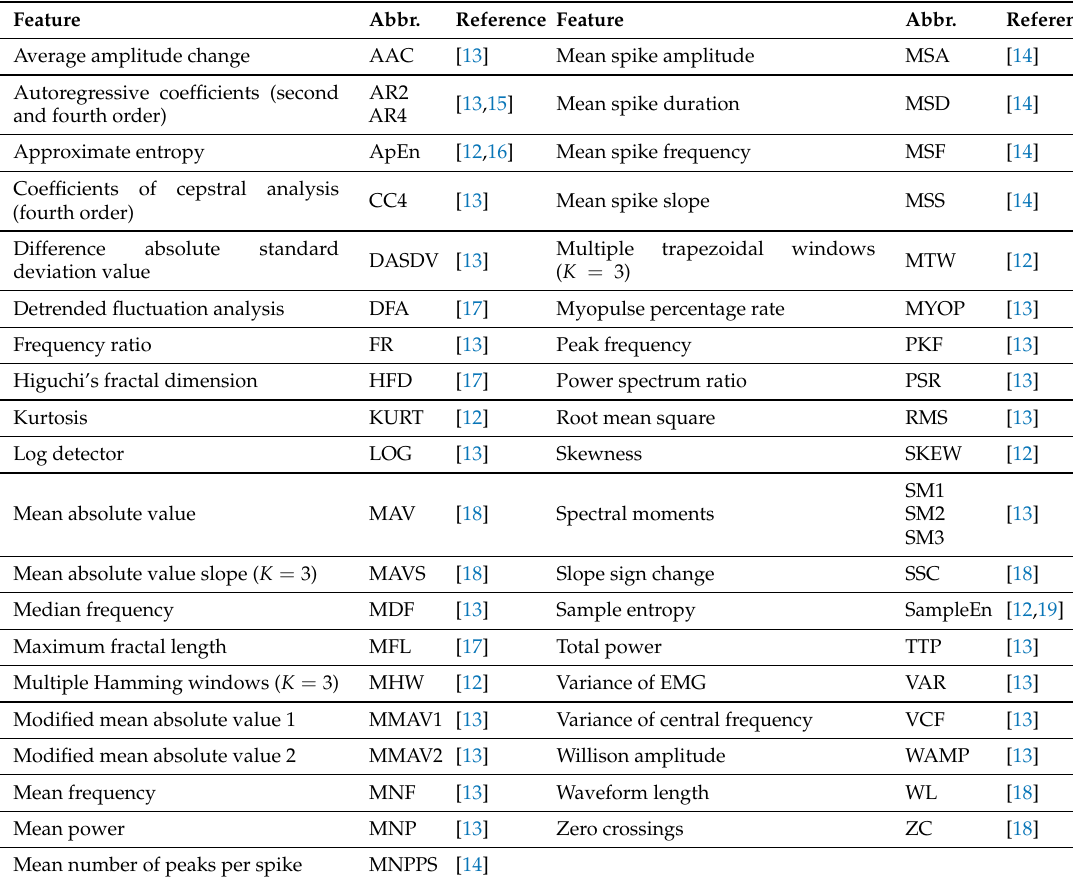
Table 1. List of common sEMG features with references. K is the number of window segments used for multi-window